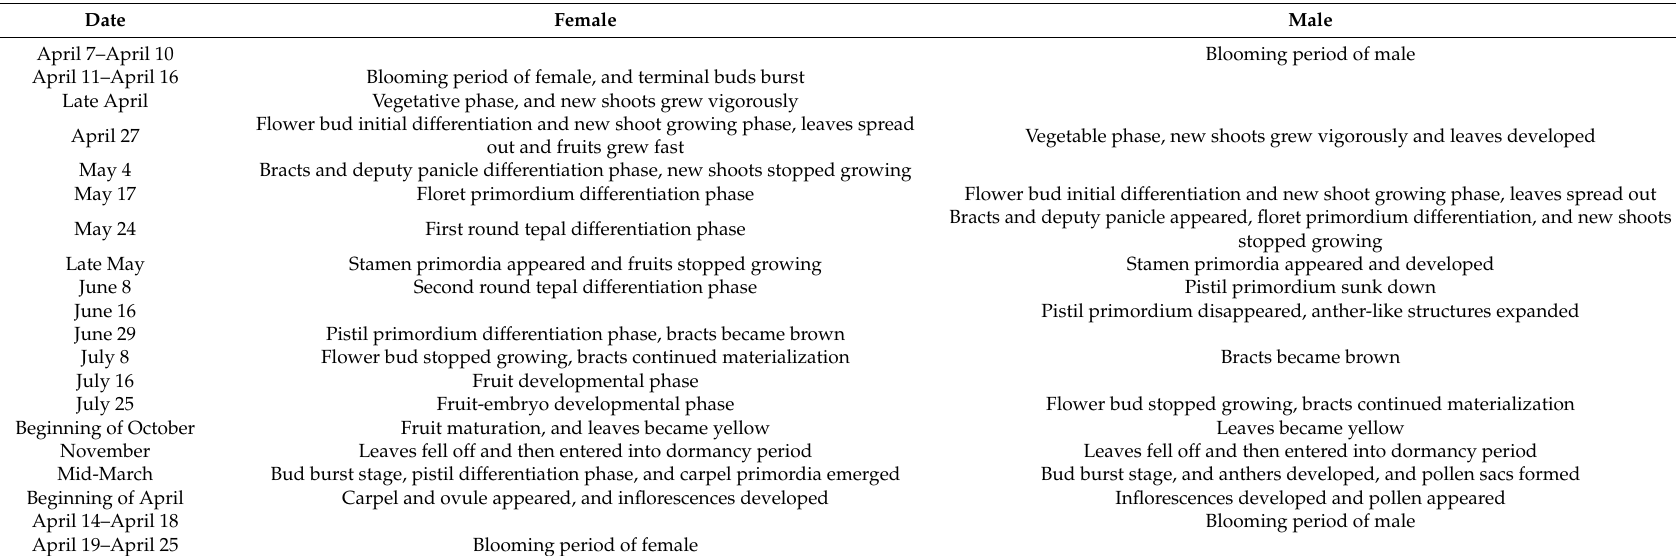
Table 4. Ontogenetic timeline of floral development on monoecious Pistacia chinensis from 2015 to